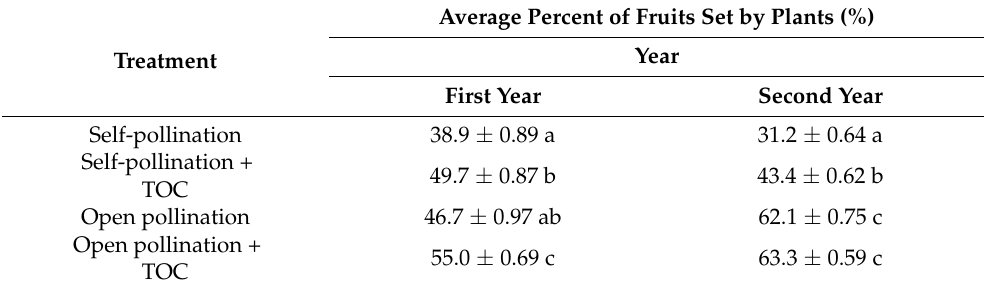
Table 2. The effect of experimental factors: type of pollination and application of titanium organic complex (TOC) on average percent of fruits set by blueberry plants (%).